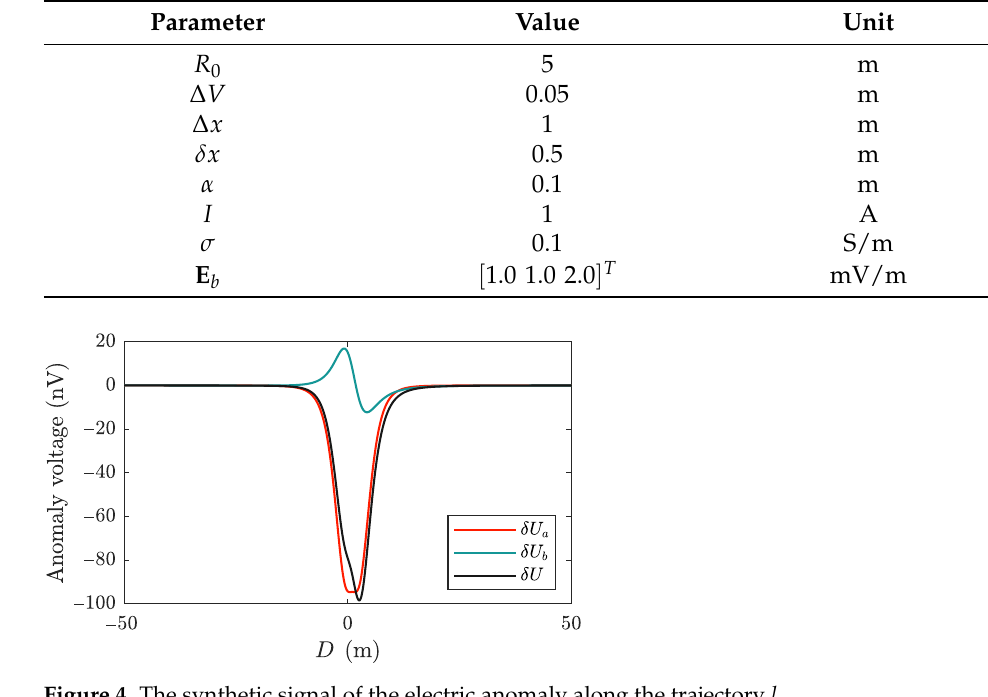
Figure 4. The synthetic signal of the electric anomaly along the trajectory l .